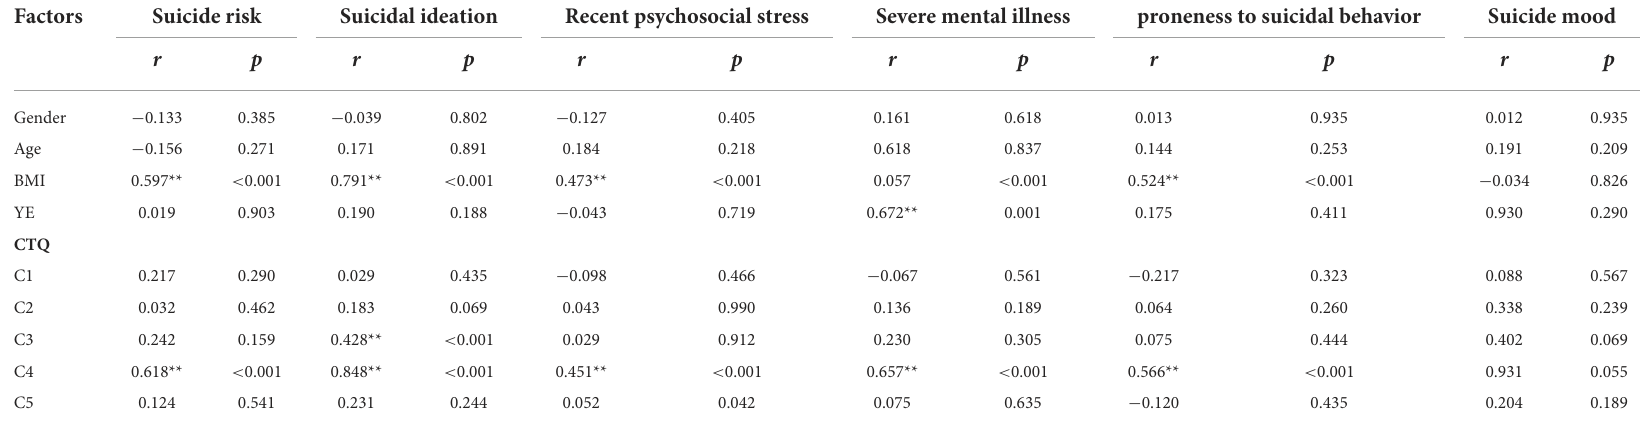
TABLE 3 Correlation between demographic and childhood trauma risks with suicide factors in the relapse group. Factors